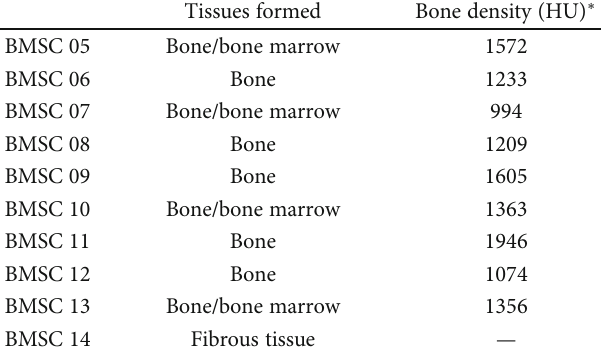
Figure 3: In vitro osteogenic, adipogenic, and chondrogenic potential of BMSC products. Representative images of (a) a noninduced BMSC layer, (b) mineralized nodules visualized by Von Kossa staining, and (c) intracellular lipid accumulation stained with Oil Red O. (d – i) Chondrogenic di ff erentiation: (d) H&E staining, (e, f) Masson Trichrome staining, and (g-i) immuno fl uorescence staining of collagen II in representative BMSC micromass pellet cultures with di ff erentiation towards the chondrogenic lineage. Cartilage matrix deposition (blue) in the extracellular matrix was assessed by Masson Trichrome staining and con fi rmed by immuno fl uorescence staining for collagen II. Representative images of n = 10 experiments. For the immuno fl uorescence analysis, n = 3 . Table 6: Osteogenic potential of the lots of BMSCs produced. Tissues